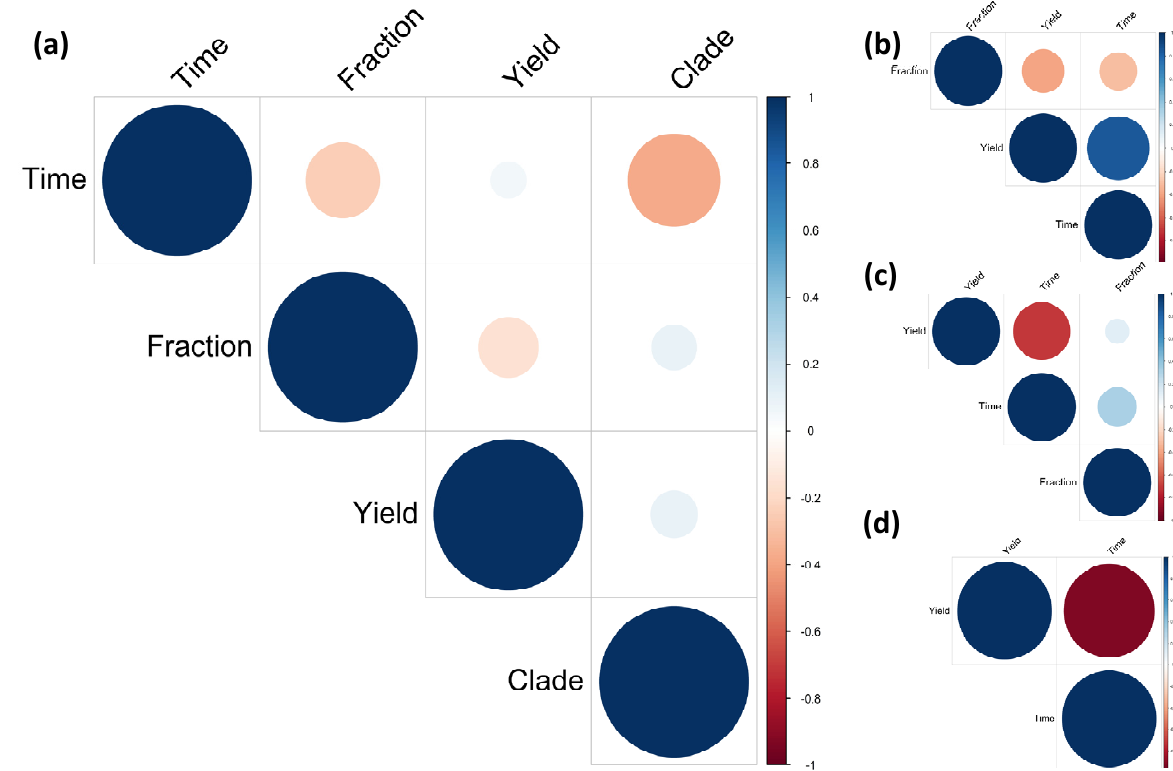
Figure 5. Correlation plot of the most abundant clades. Spearman correlation among time, environmental variables and obtained yields. ( a ) All retrieved clades were compared with time and environmental variables. Yield obtained within ( b ) clade 5, ( c ) clade 6 were compared with time and fraction variables. For clade 7 ( d ), includes only isolates sampled from liquid fraction.